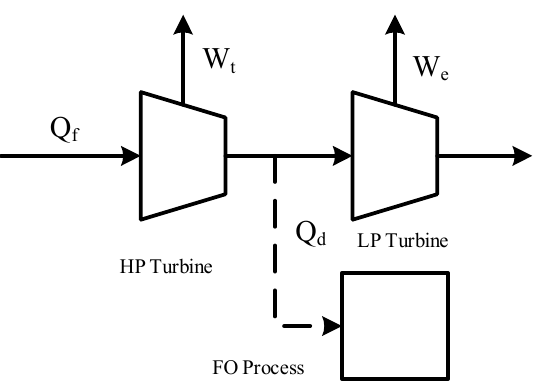
Figure 14. Schematic diagram of cogeneration power desalting plant.